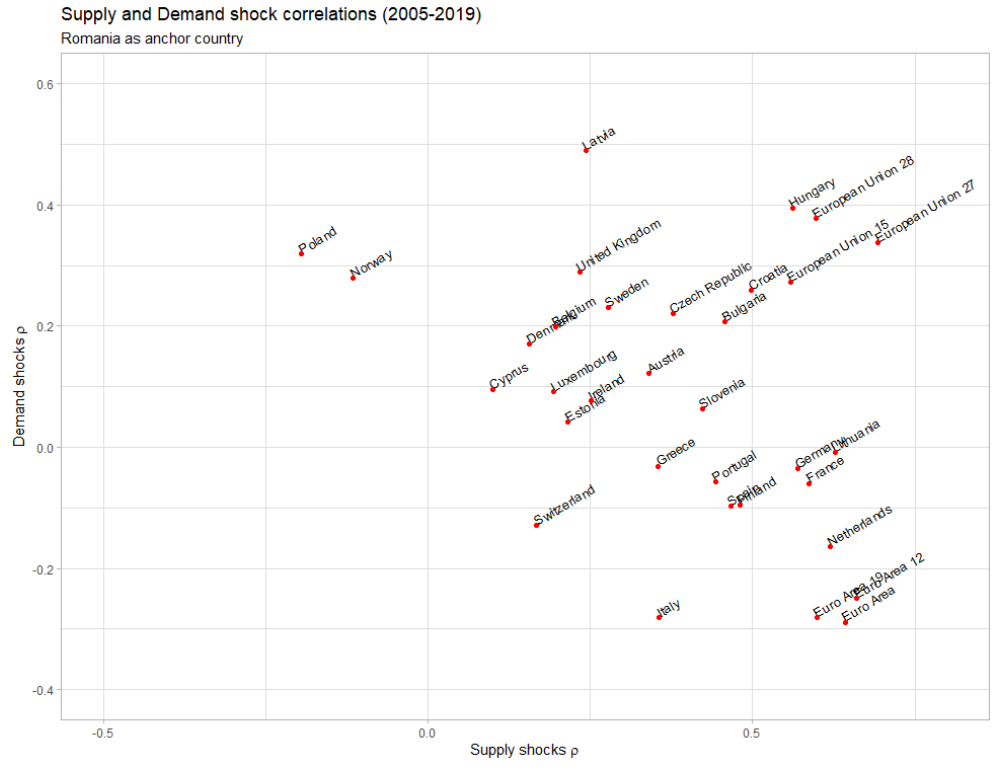
Figure 7. Bidimensional mapping of the correlation coefficients (ρ) between supp ly and demand shocks series recuperated from the BQ model using the sample after the breaking point (2005-2019) – Romania as anchor country. Source: own